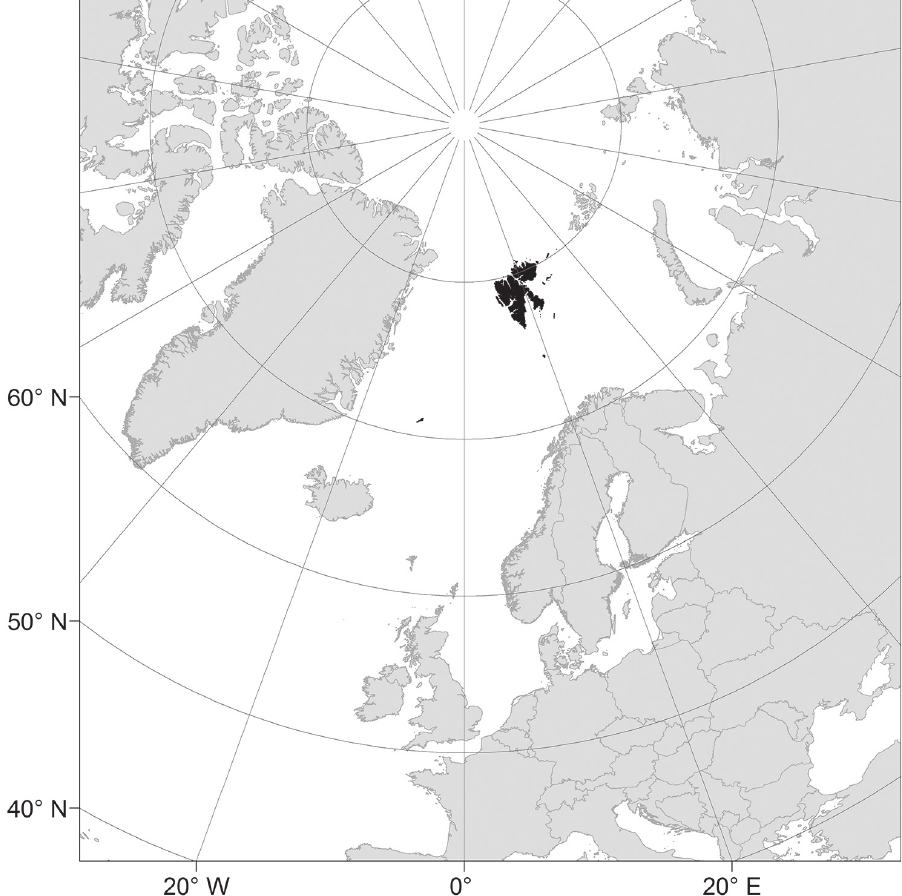
Figure 1. Geographical location of the study site Svalbard (highlighted in